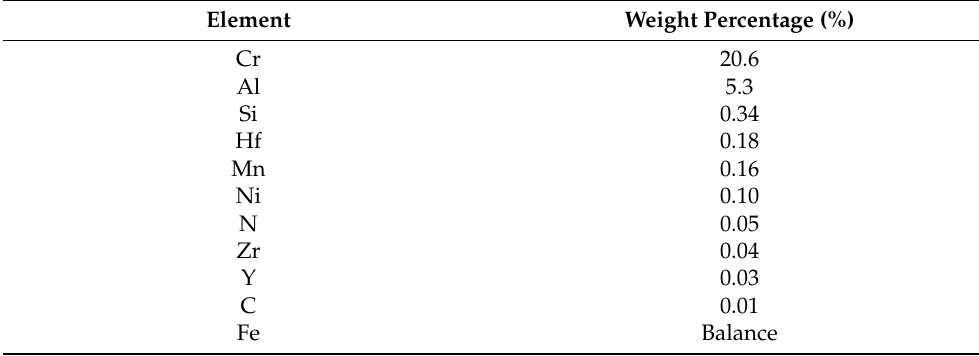
Table 1. Chemical composition of the powder.